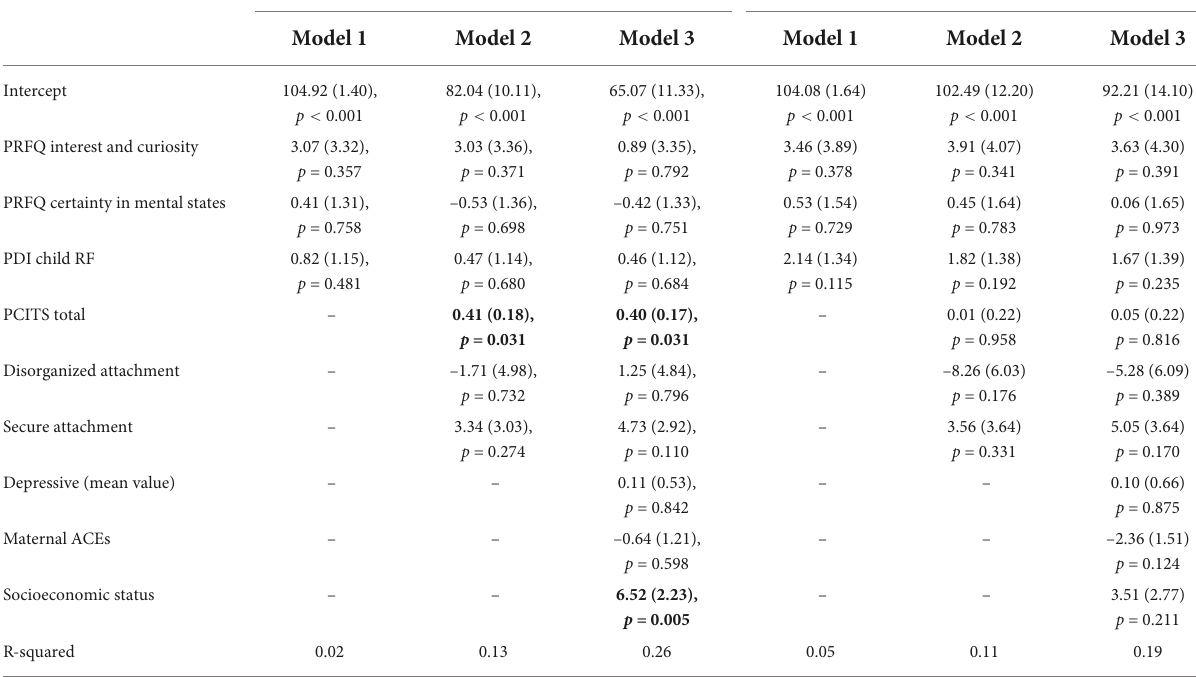
TABLE 4 Full scale IQ and visual spatial stepwise linear